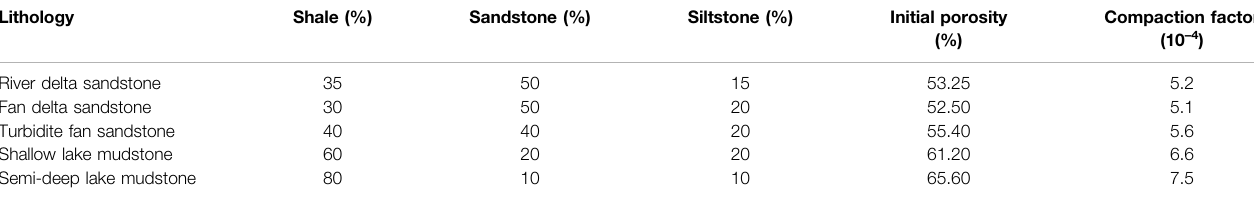
TABLE 2 | Lithostratigraphy, physical, and thermal properties of sedimentary sequences de fi ned in the model.